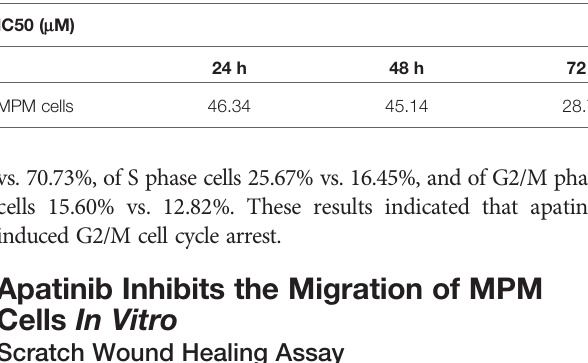
The cell migration rates in blank control, solvent control and apatinib group (25 m M and 50 m M) were (77.52 ± 2.54) %, (78.50 ±